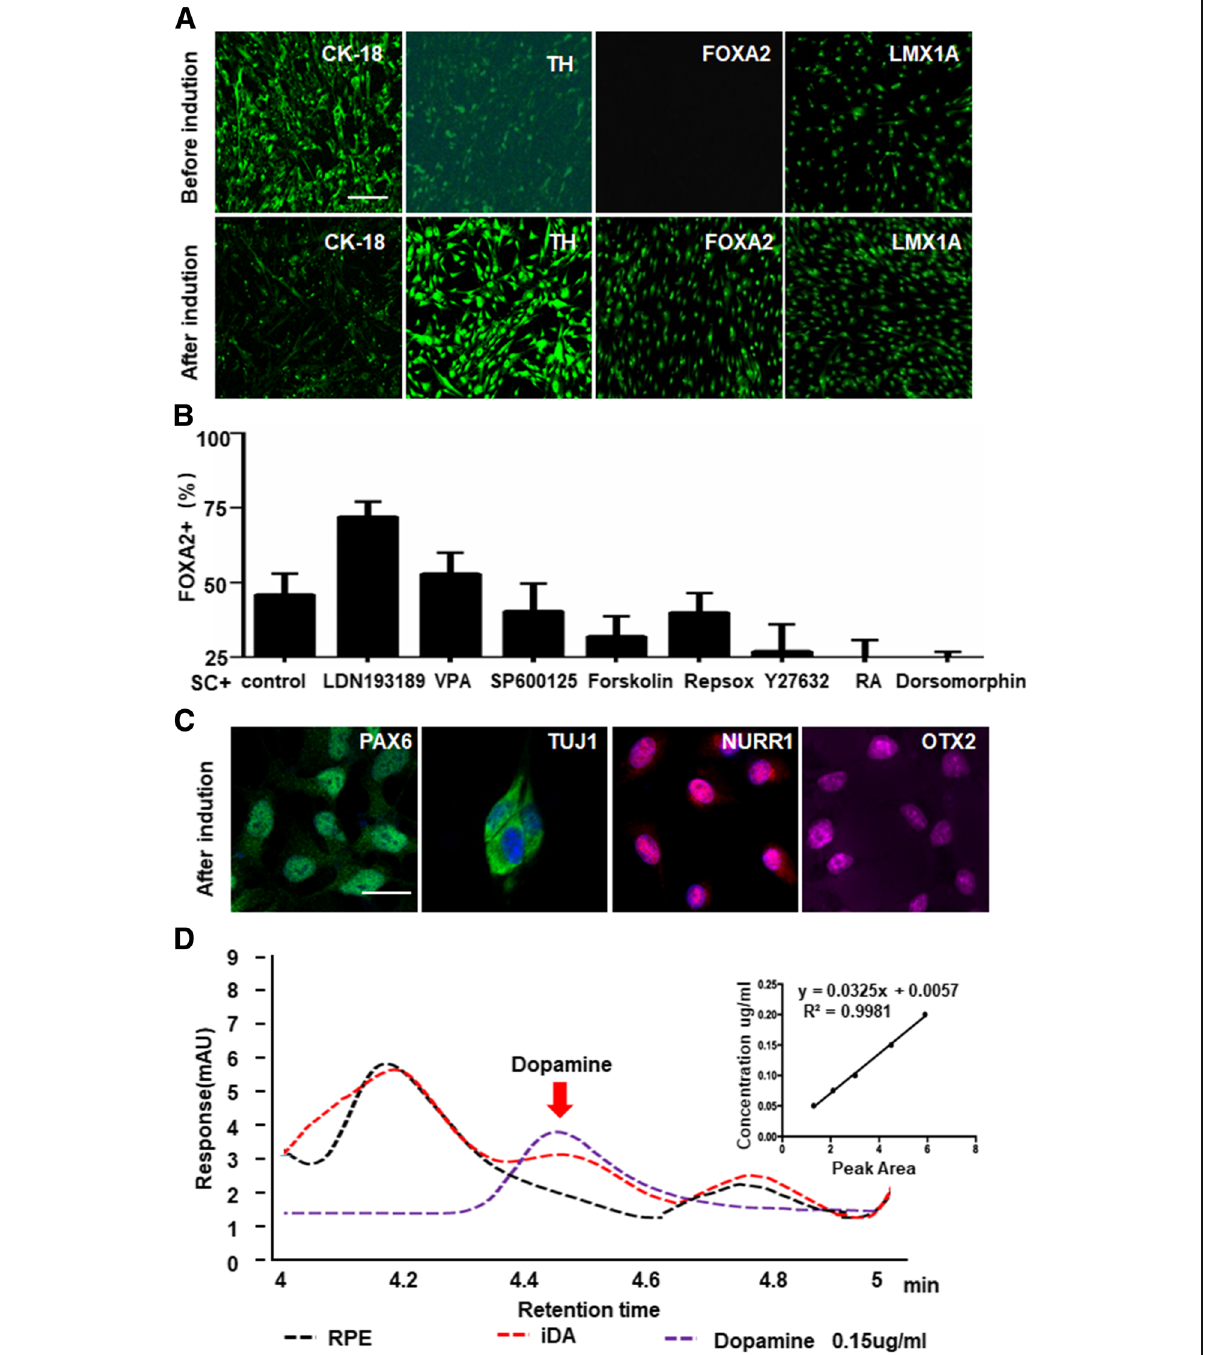
Fig. 3 Chemically induced reprogramming of RPE cells into dopamine-producing cells. a Immunofluorescent staining of RPE cells before or 4 days after induction for CK-18, TH, FOXA2, and LMX1A, (scale bar: 100 μ m). b Percentage of FOXA2 + cells in chemical induction systems with different small molecules. Com SC, combination of SB431542 and CHIR99021 was used as control. (Statistical analysis from Fig. S2A). Dates are expressed as mean + SD. c Chemically induced RPE cells expressed neuronal markers, including PAX6, NURR1, TUJ1, and OTX2 (scale bar: 20 μ m). d Determination of dopamine by high-performance liquid chromatography (HPLC; red, the supernatant from cultured RPE cells after chemical induction; purple, 0.15 μ g/ml dopamine standards; black, supernatant from cultured RPE cells before induction). Linear calibration curve of dopamine concentrations. The curve was plotted by integrated peak area ratio versus